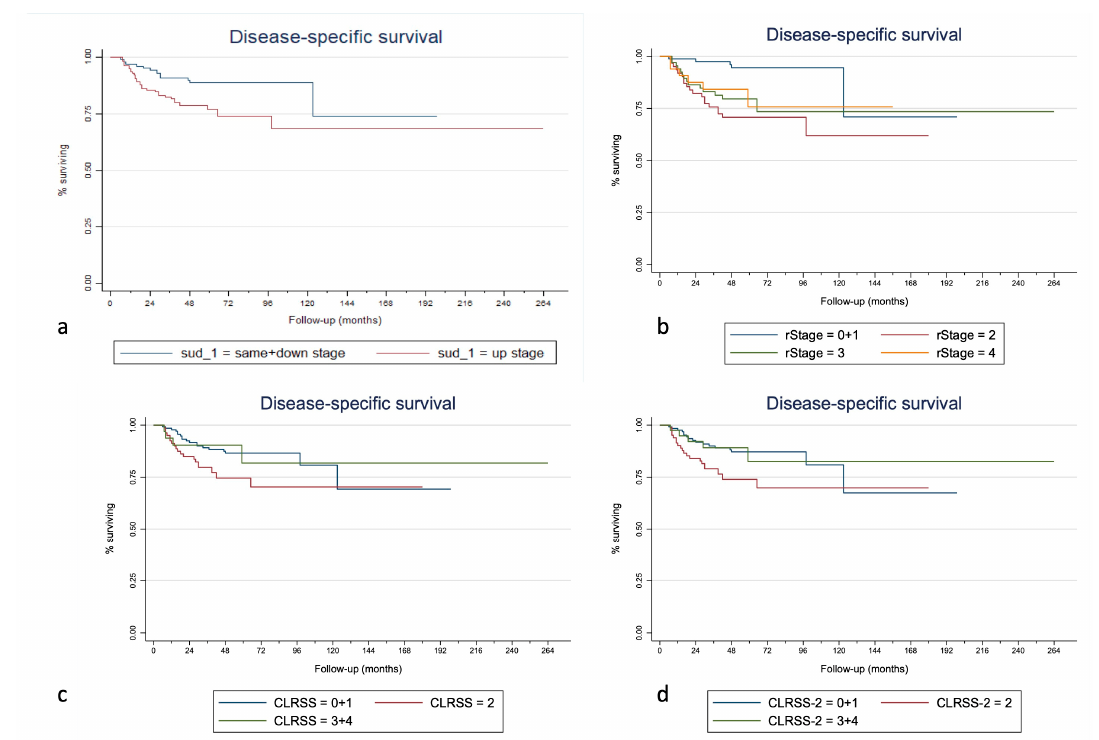
Figure 3. Kaplan–Meier curves for disease-specific survival stratified for the SUD ( a ), rTNM ( b ), CLRSS ( c ), and CLRSS-2 ( d ) staging classes (merged as the analyses were performed).